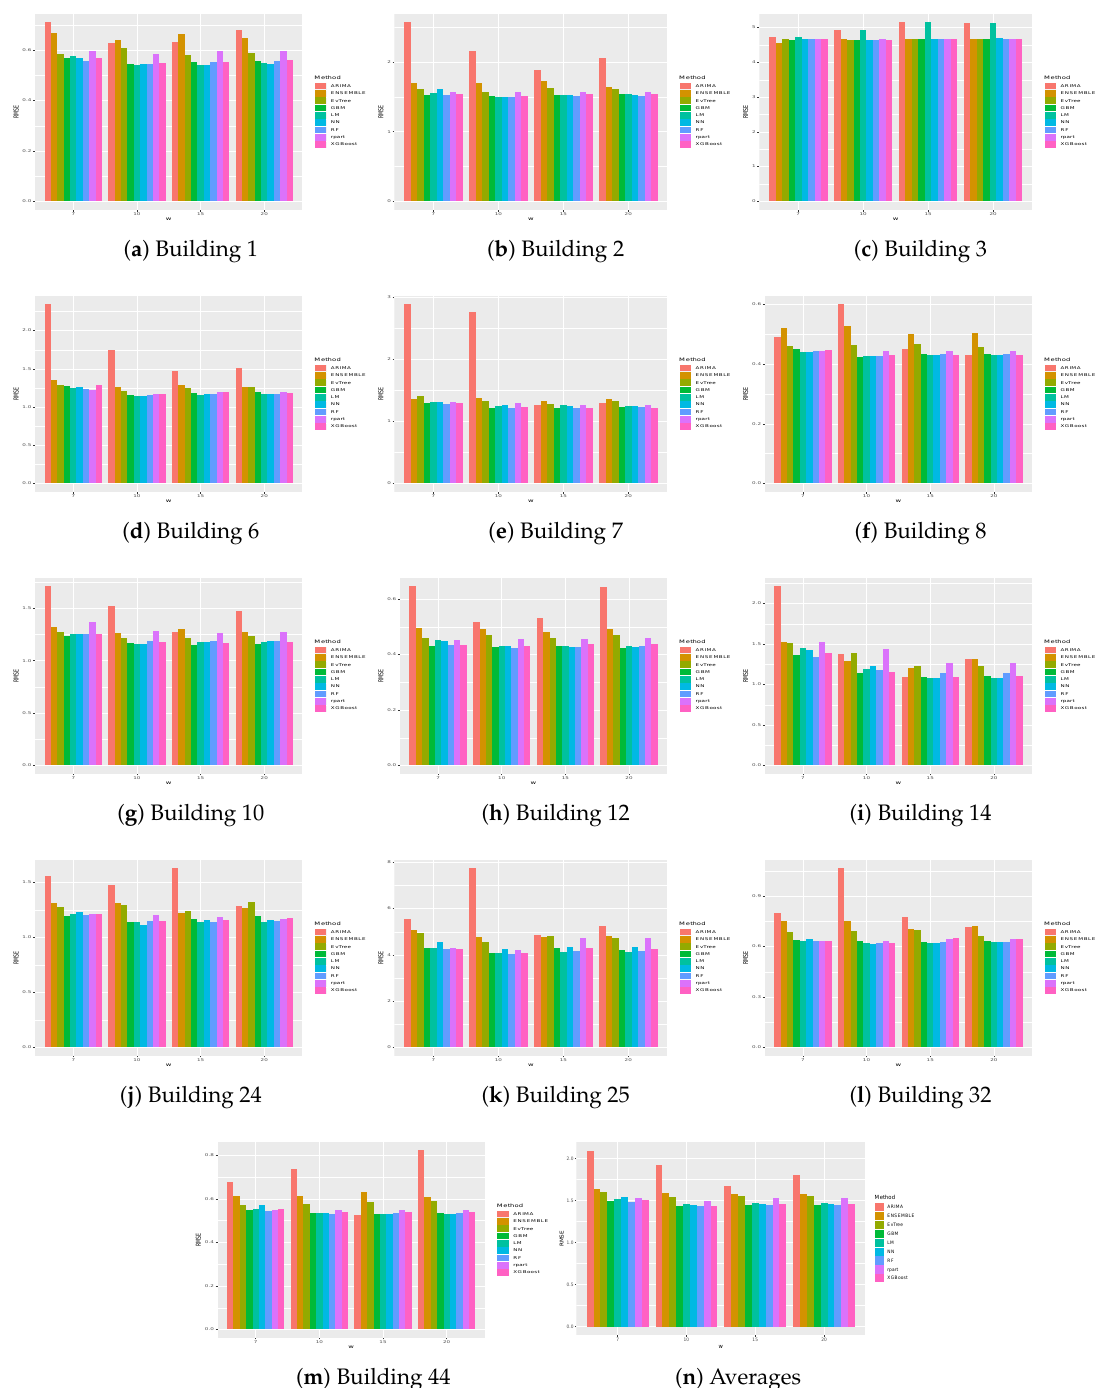
Figure A2. Comparison of the RMSE obtained on the different